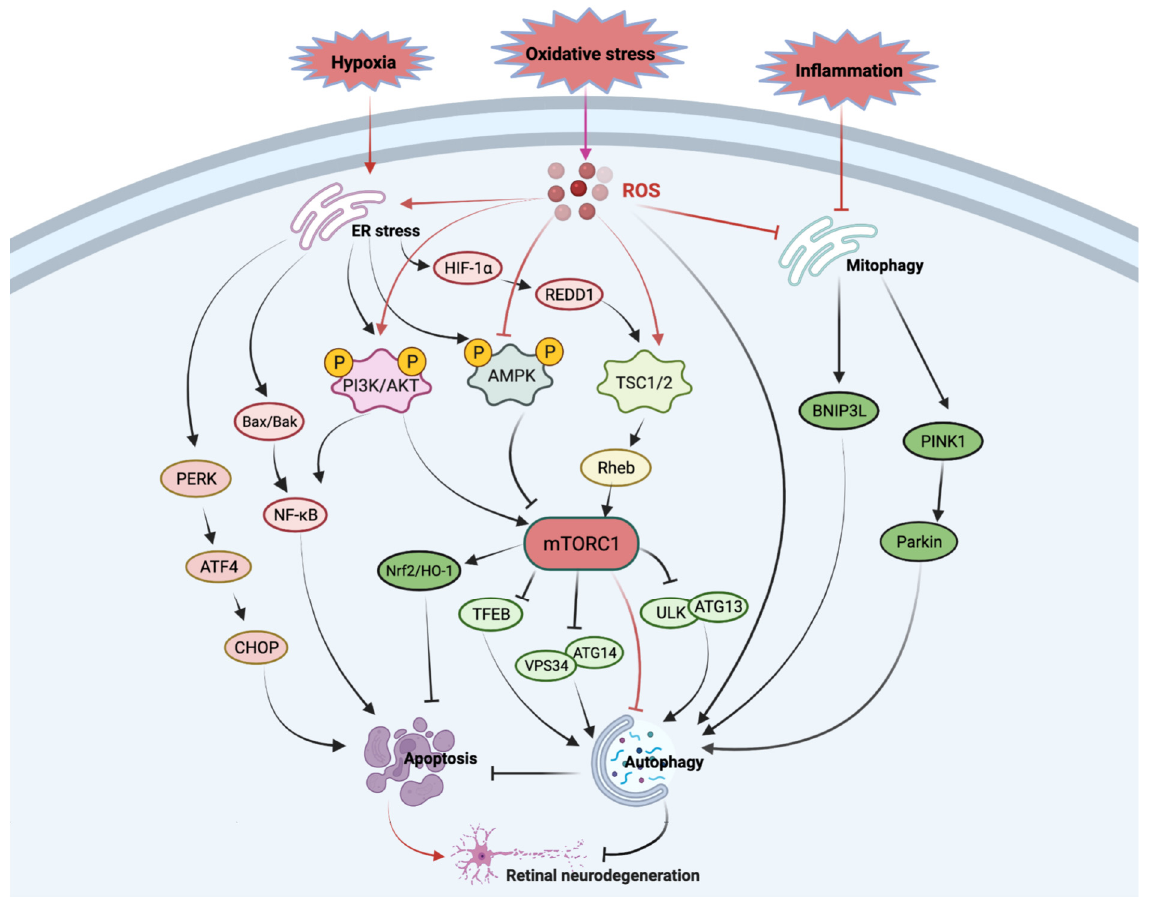
Figure 1. The common mTOR signalling pathway in ocular neurodegenerative diseases. Abbrevia- tions: AMP’, 5’ adenosine monophosphate-activated protein kinase; ATF4, activating transcription factor 4; ATG, autophagy-regulating protease; BNIP3L, adenovirus E1B 19 kDa protein-interacting protein 3-like; CHOP, C/EBP homologous protein; ER, endoplasmic reticulum; HIF-1 α , hypoxia- inducible factor 1-alpha; HO-1, heme oxygenase-1; mTORC1, mammalian target of rapamycin complex 1; Nrf2, nuclear factor-erythroid factor 2-related factor 2; PERK, protein kinase R (PKR)-like endoplasmic reticulum kinase; PI3K, phosphoinositide 3-kinase; PINK1, PTEN-induced kinase 1; REDD1, regulated in development and DNA damage responses 1; Rheb, ras homolog enriched in brain; ROS, reactive oxygen species; TFEB, transcription factor EB; TSC, tuberous sclerosis complex; ULK1, unc-51-like kinase 1; VPS34, vacuolar protein sorting 34. In addition to AKT, mitogen-activated protein kinase (MAPK) and proinflammatory cytokine TNF α also promote the activation of mTORC1 through inhibiting TSC1/TSC2 [37]. Wnt/ β -catenin signalling plays a role in regulating mTORC1 by suppressing glycogen